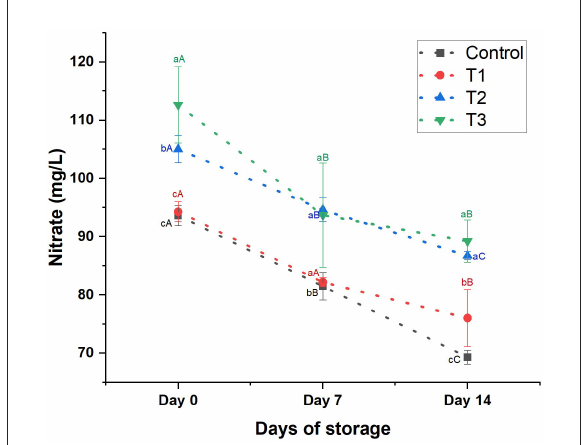
FIGURE6 Nitrate content (mg/L) of control beverage and beverages enriched with beetroot peel extracts at different concentrations. Means with different lowercase letters (a–d) on the same storage day are statistically different ( p < 0.05). Means with different uppercase letters (A–C) for each treatment during the different storage days are statistically different ( p < 0.05).